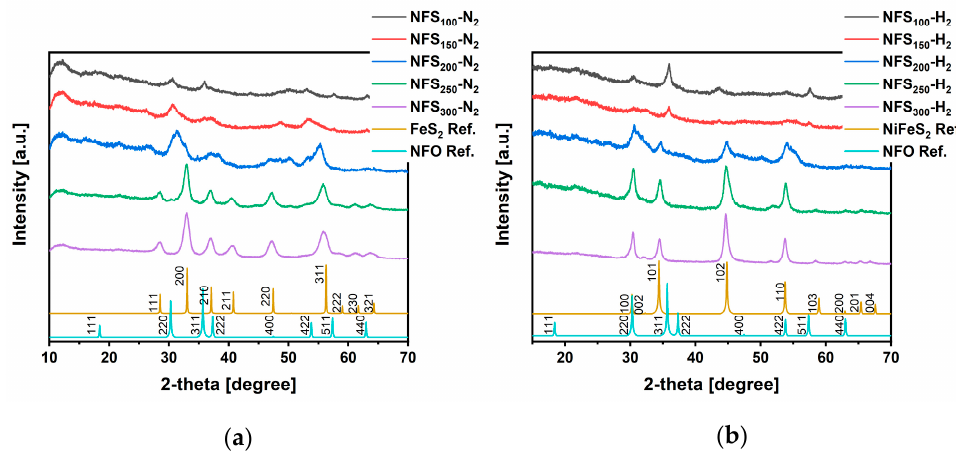
Figure 1. Powder X-ray diffractograms of NFS materials synthesized at temperatures between 100 and 300 °C using ( a ) H 2 S/N 2 and ( b ) H 2 S/H 2 reaction atmospheres [32–34].